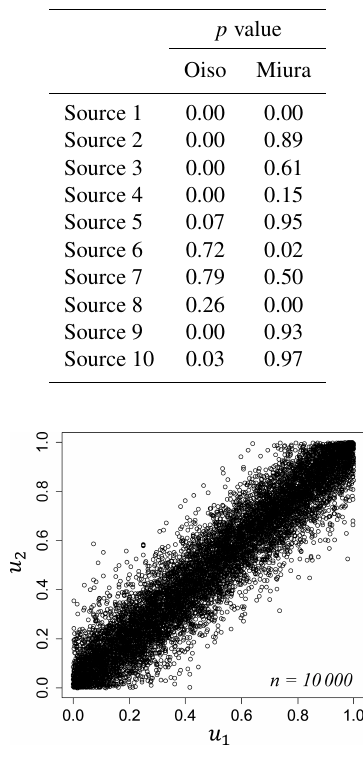
Figure 9. Selected Frank copula for source 8.